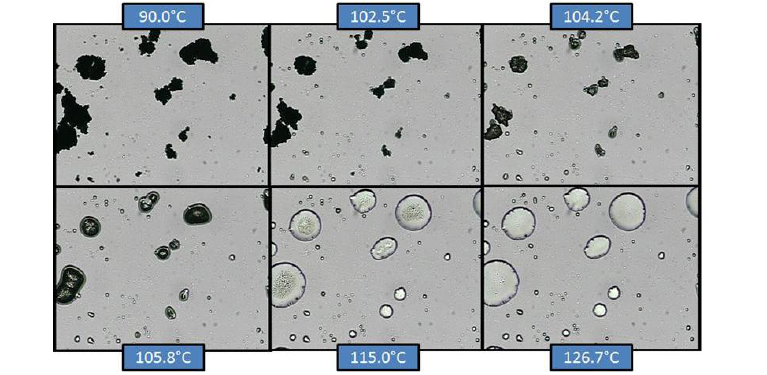
Figure 10. Hot-stage microscopy (HSM) of co-micronized EFV:SLS